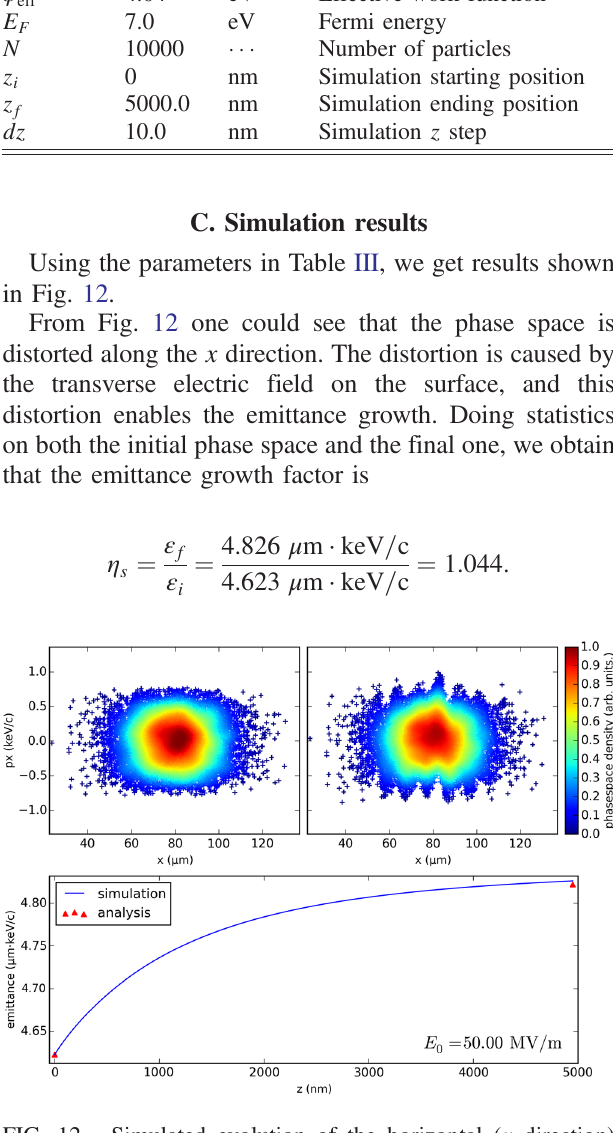
FIG. 12. Simulated evolution of the horizontal ( x direction) phase space and emittance of the electron beam generated from the rough copper surface (Fig. 10). The upper left subplot is the initial phase space at z ¼ 0 nm, the upper right subplot is the final phase space at z ¼ 5000 nm, and the lower subplot is the evolution of ε along z . The two red triangles in the lower x subplot are the initial analytical emittance and final analytical emittance,